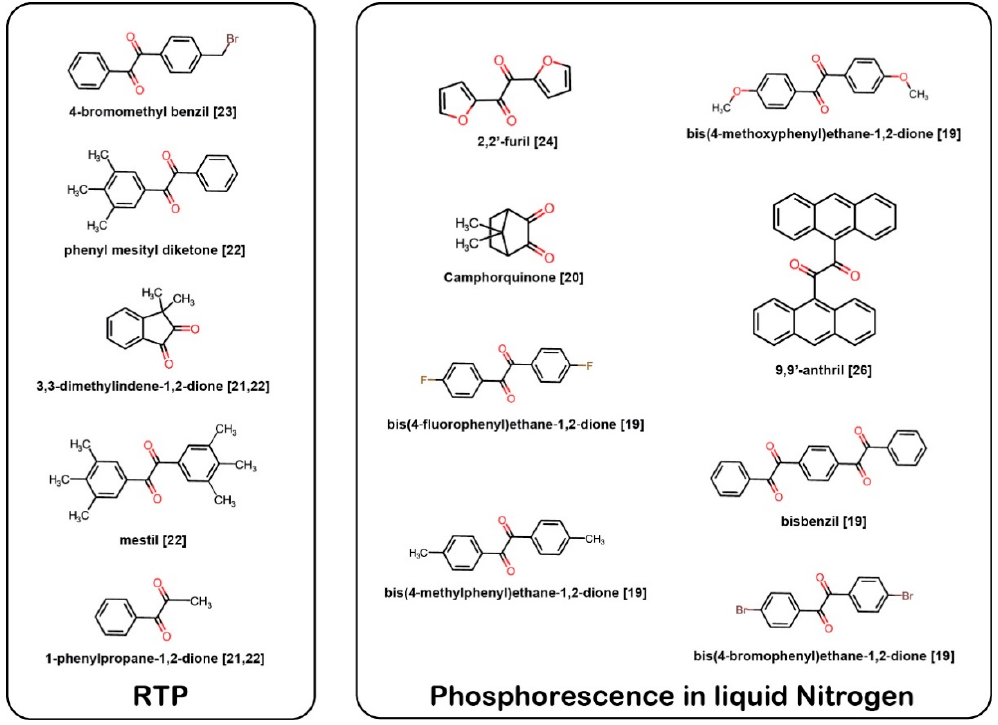
Figure 1. α -dicarbonyl molecules such as benzil and benzil derivatives reported to emit room-temperature phosphorescence (RTP) or phosphorescence at 77 K.